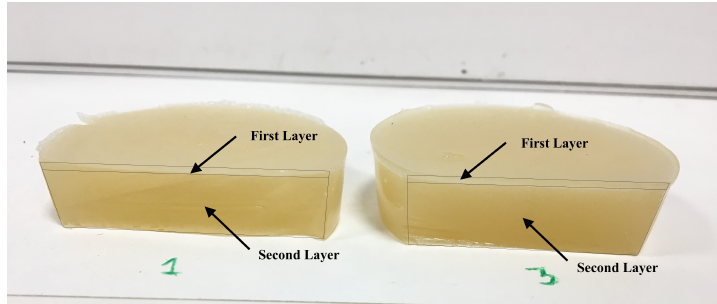
Figure 2. Phantoms number 1 and 3. The phantoms were unmolded and cut to appreciate the two layers of which they are composed.